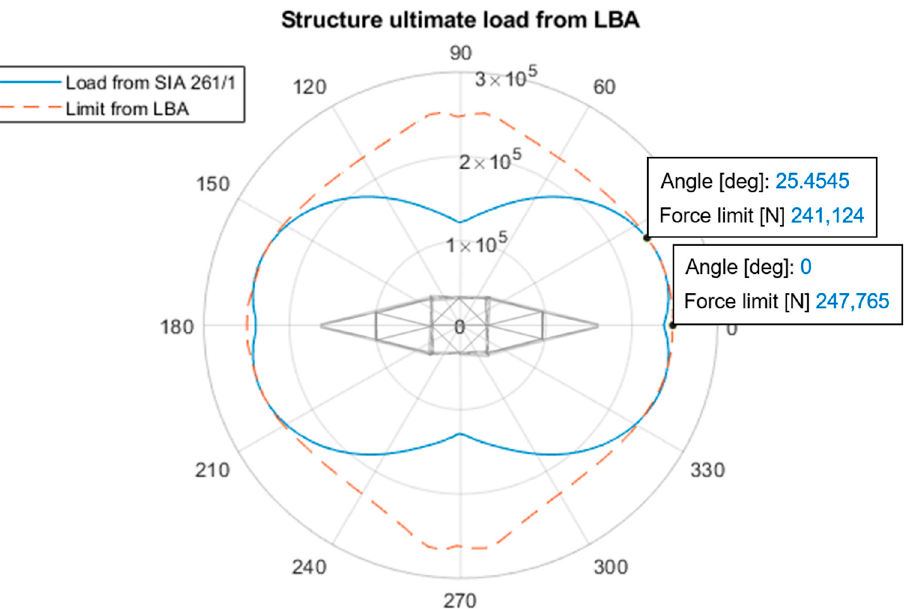
Figure 21. Instability load from LBA, in terms of total load (in N), compared with the SIA 261/1 load case. The LBA values at 0° and at 25.4° in the transverse direction, extremely close to the design load case, are highlighted.